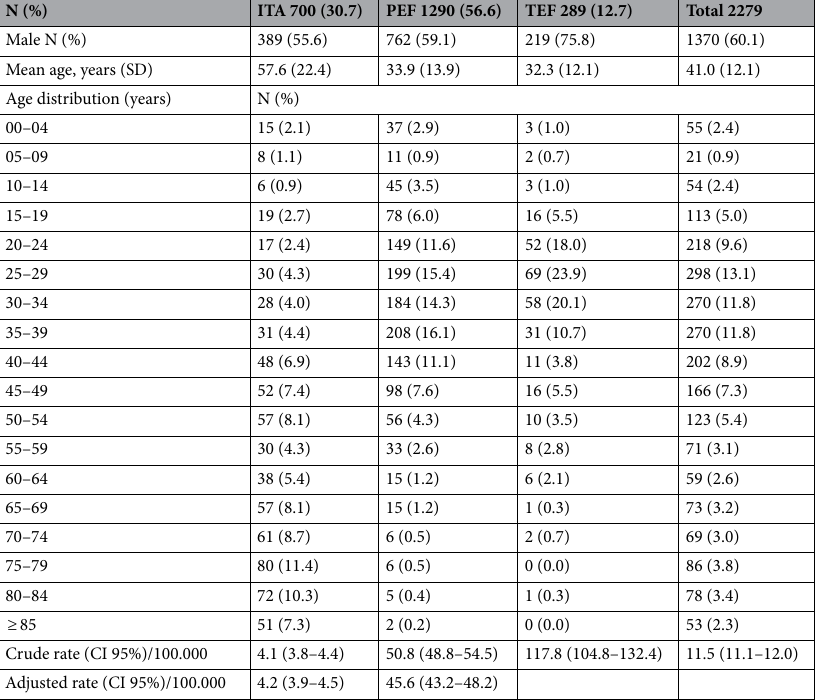
Table 1. Sex and age distribution of TB cases and relative crude and adjusted rates per ITA, PEF and TEF. Crude rate: crude TB notification rate (N/100,000); Adjusted rate: sex and age adjusted TB notification rate (N/100,000); CI95%: Confidence Interval 95%. Adjusted rate for TEF not measurable due to uncertainty of reference population.